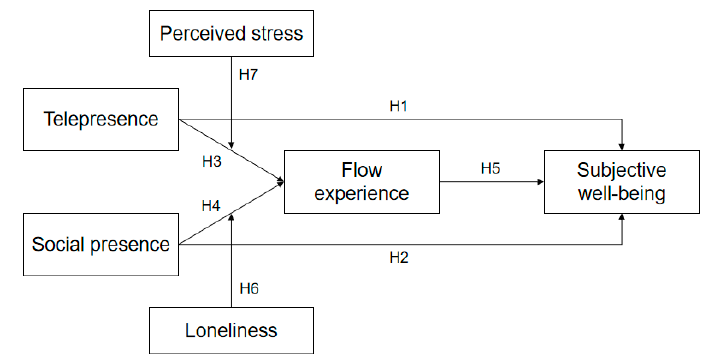
Figure 2. Model of the proposed hypotheses.